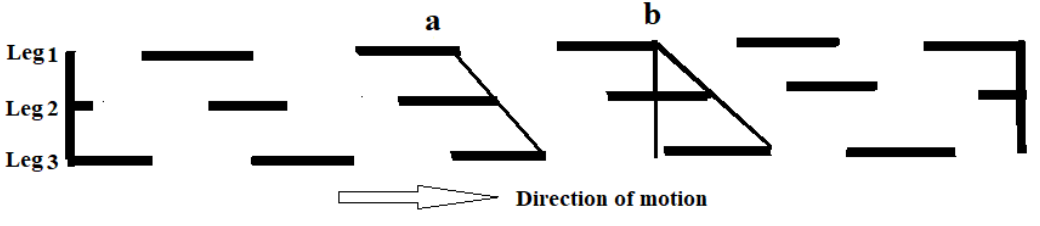
Figure 12. Metachronal gait of UMSWR.